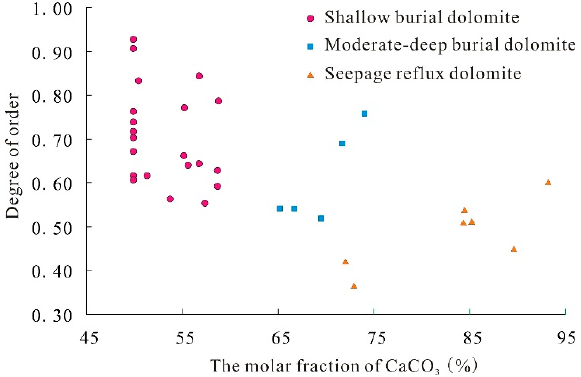
Figure 5. Relation between the degree of order and the molar fraction of calcium carbonate.